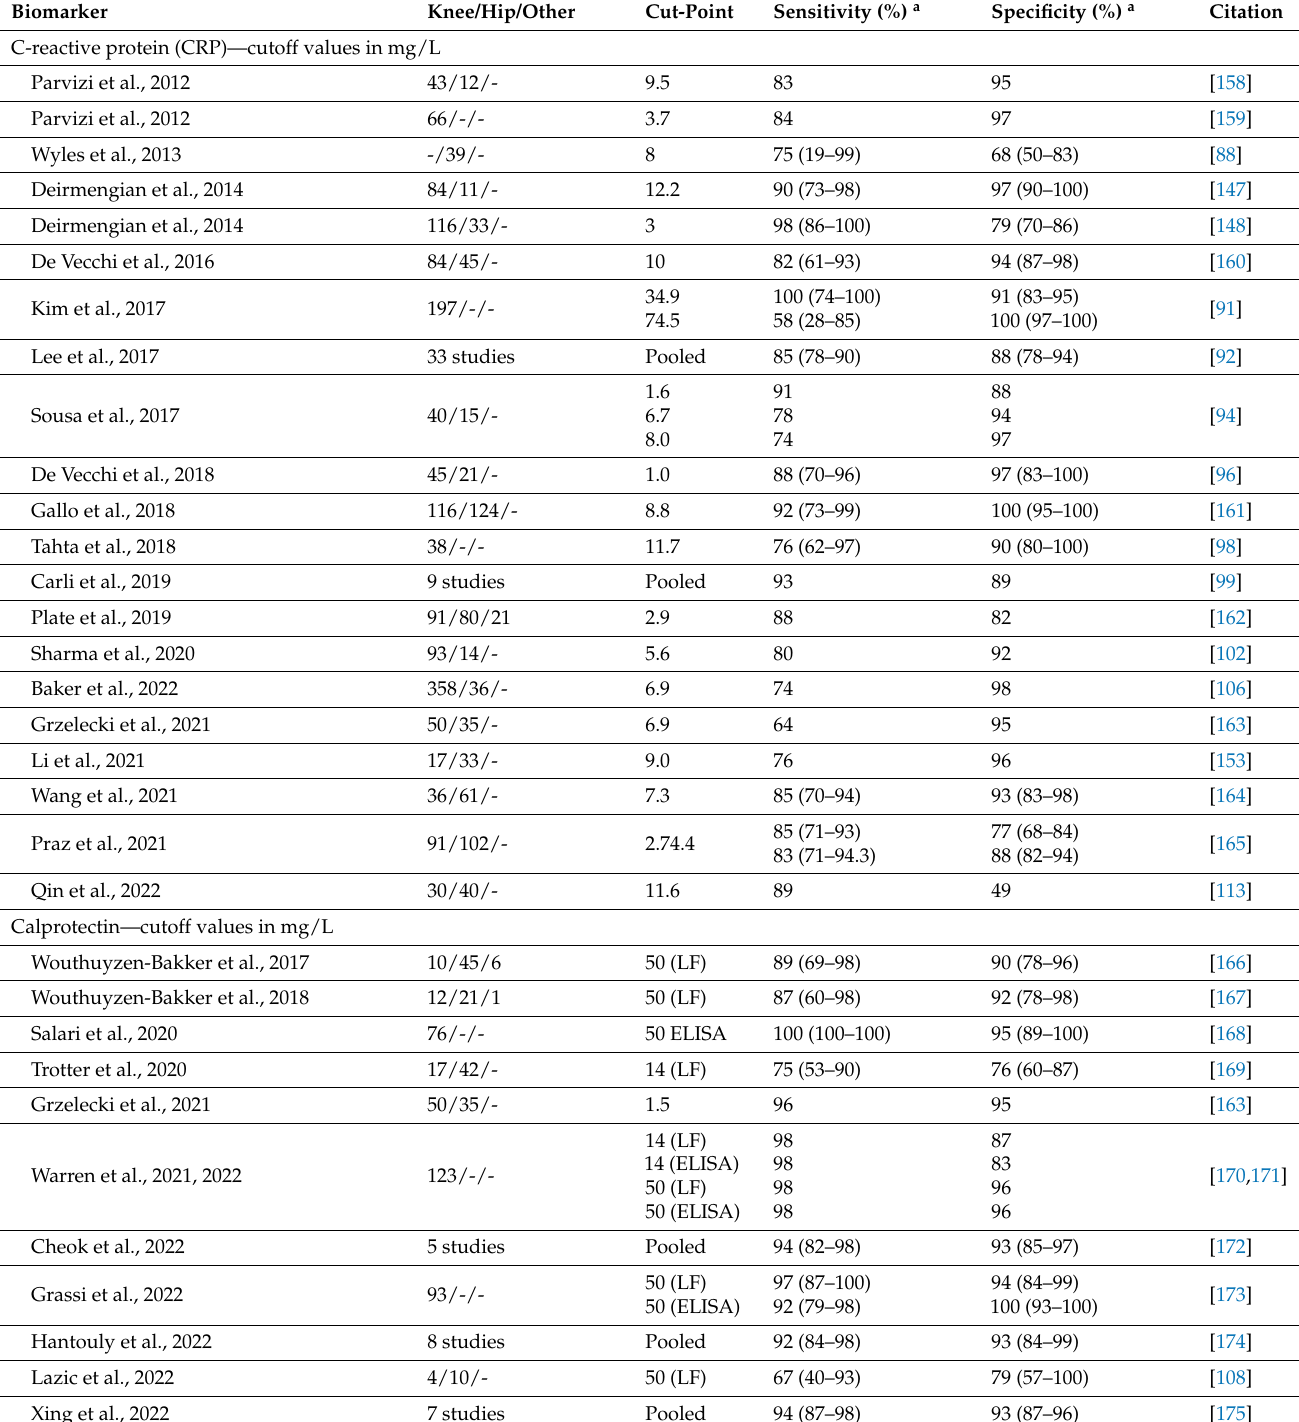
Table 3. Sensitivity and specificity of synovial fluid C-reactive protein (CRP), calprotectin,